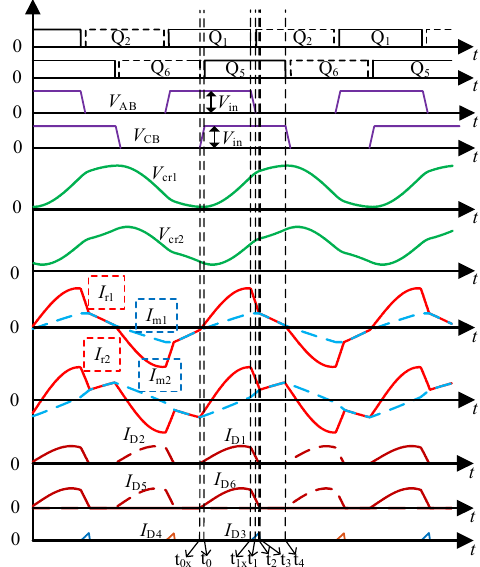
Figure 8. Main working waveform diagram of half-bridge phase-shift mode. The specific working states of full-bridge LLC resonant converters under frequency modulation control or phase-shift control and half-bridge LLC resonant converters under frequency modulation control have been described in detail in much of the literature, so only the half-bridge phase-shift control mode is analyzed